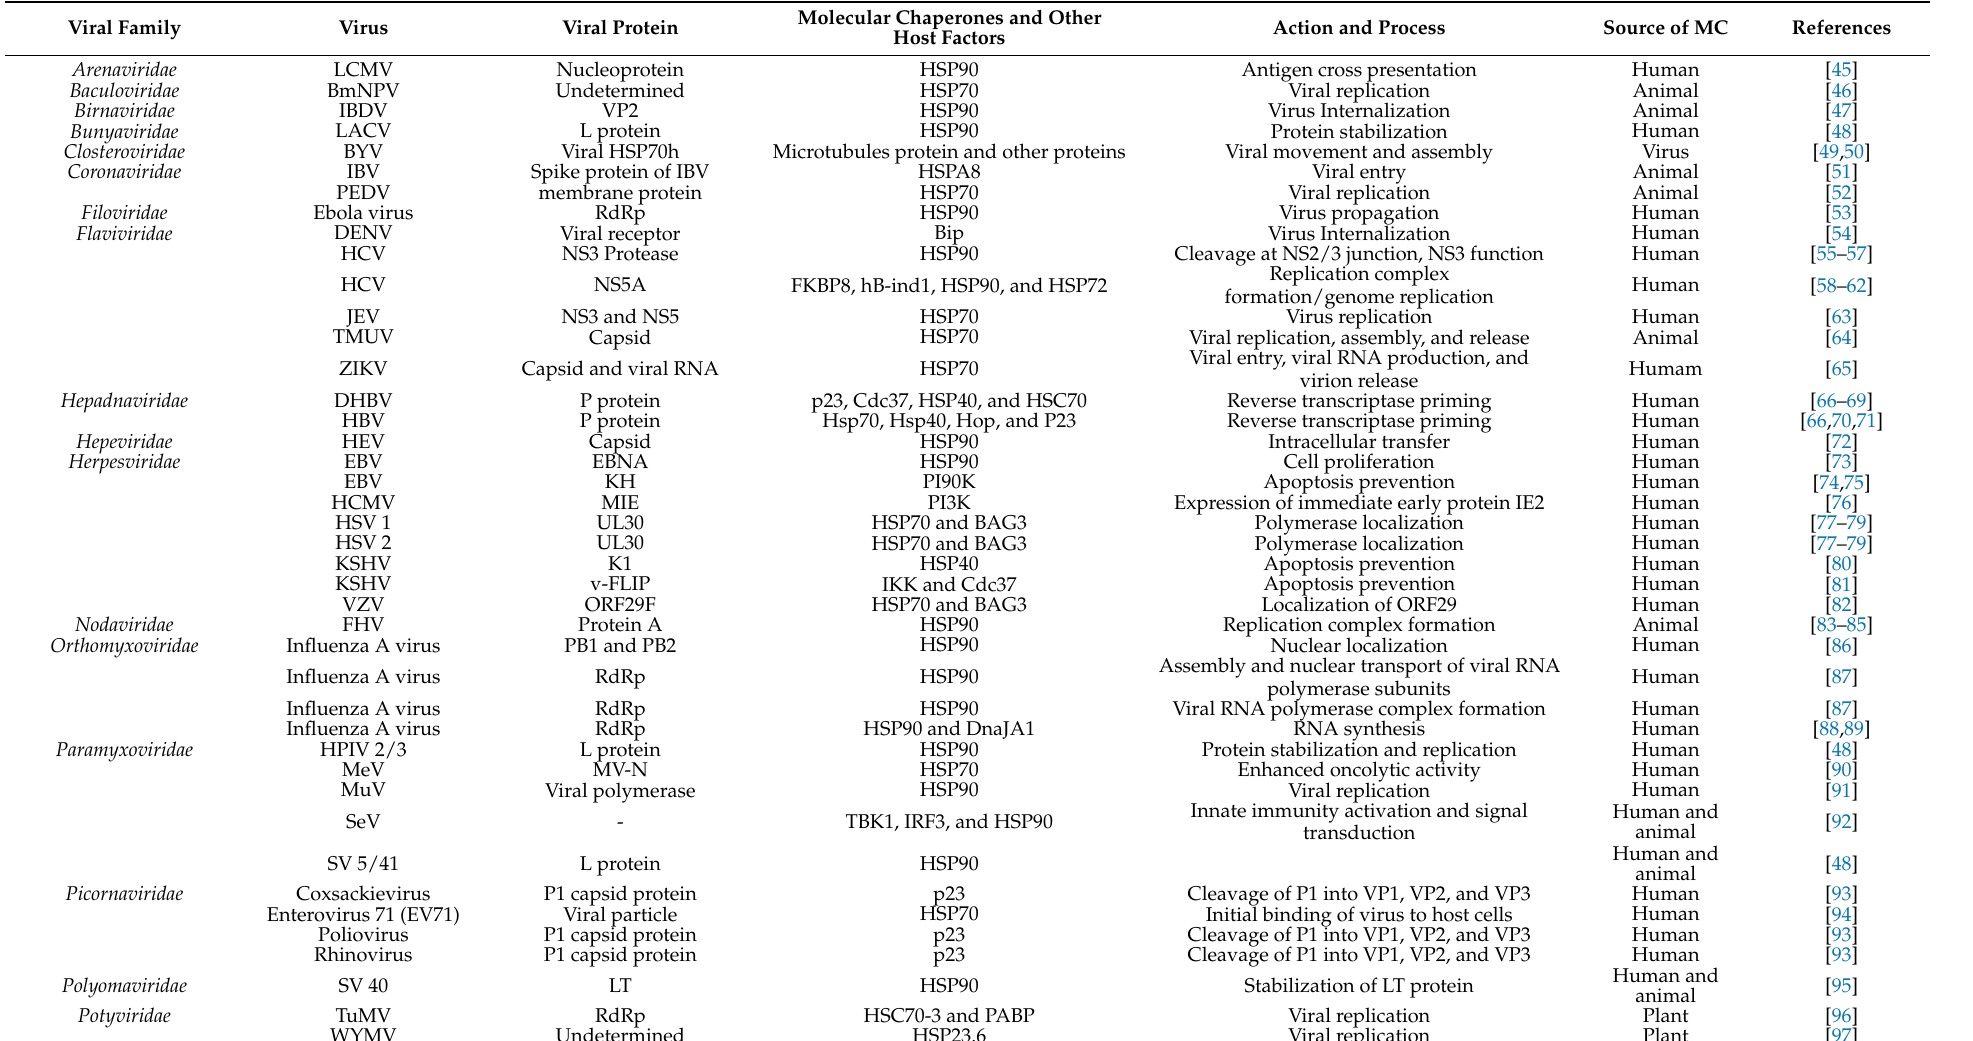
Table 1. The interaction between the MC and viral